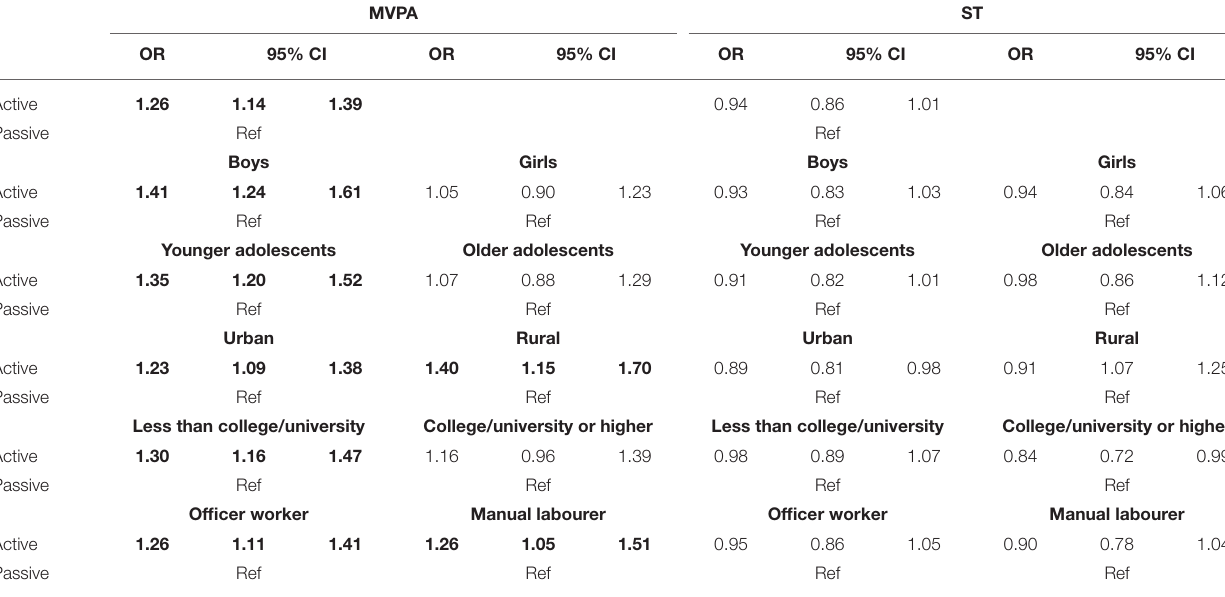
TABLE 5 | The relationships of travel (modes) to school with MVPA and ST by different